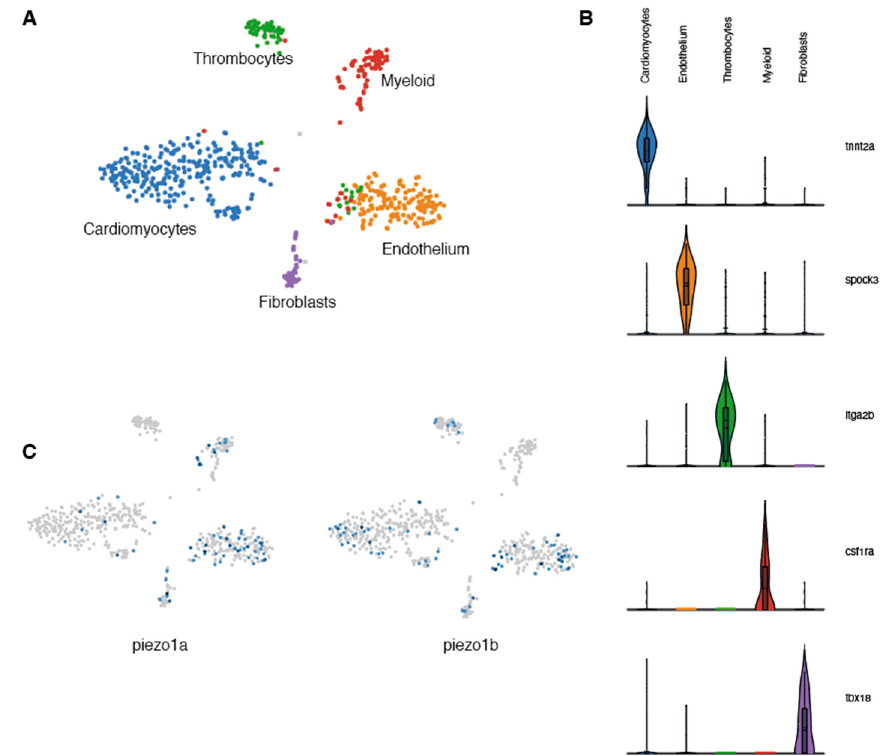
Figure 1. Single-nuclei RNAseq analysis of zebrafish Piezo expression in the heart. ( A ) UMAP clusters of the different populations of cells identified in zebrafish hearts. ( B ) Violin plots showing the 5 genes used to characterize the different cell populations. ( C ) UMAP plots indicating the cells expressing piezo1a or piezo1b